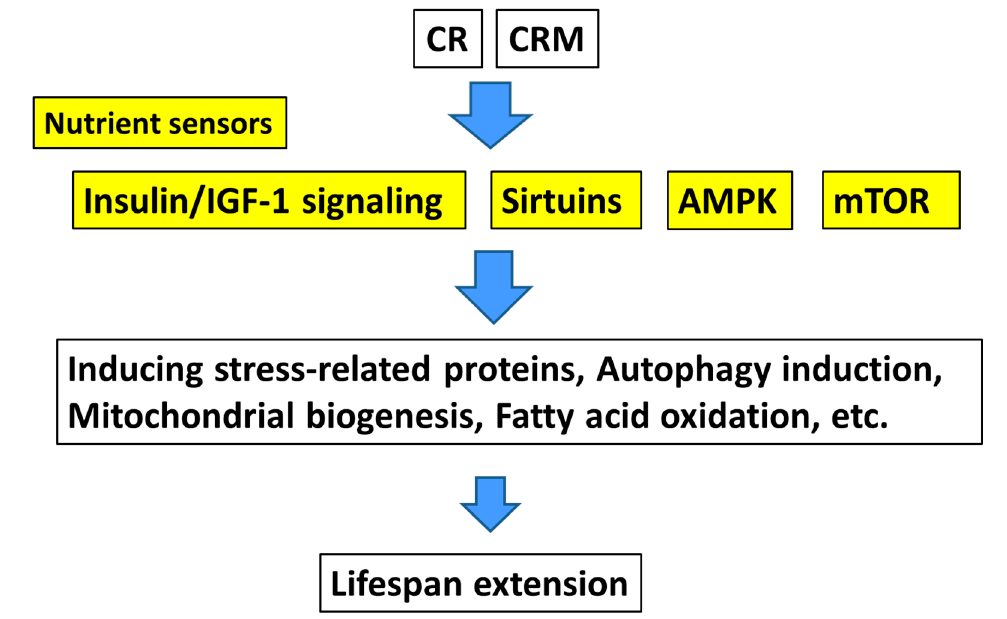
Figure 2. Postulated mechanisms of action of CR and CRMs.